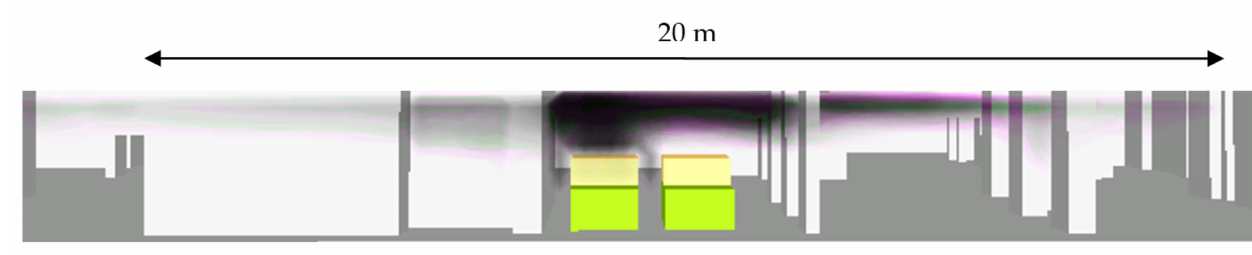
Figure 6. Detection activation—starting fire alarm.